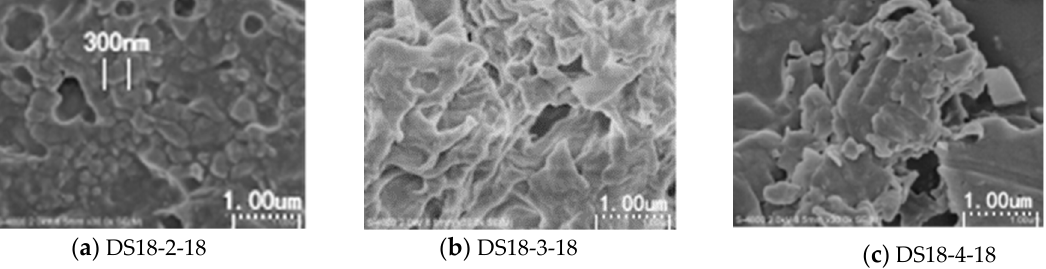
Figure 3. Effect of spacer group on the viscosity of DS18-s-18 solution(s = 2, 3, 4).